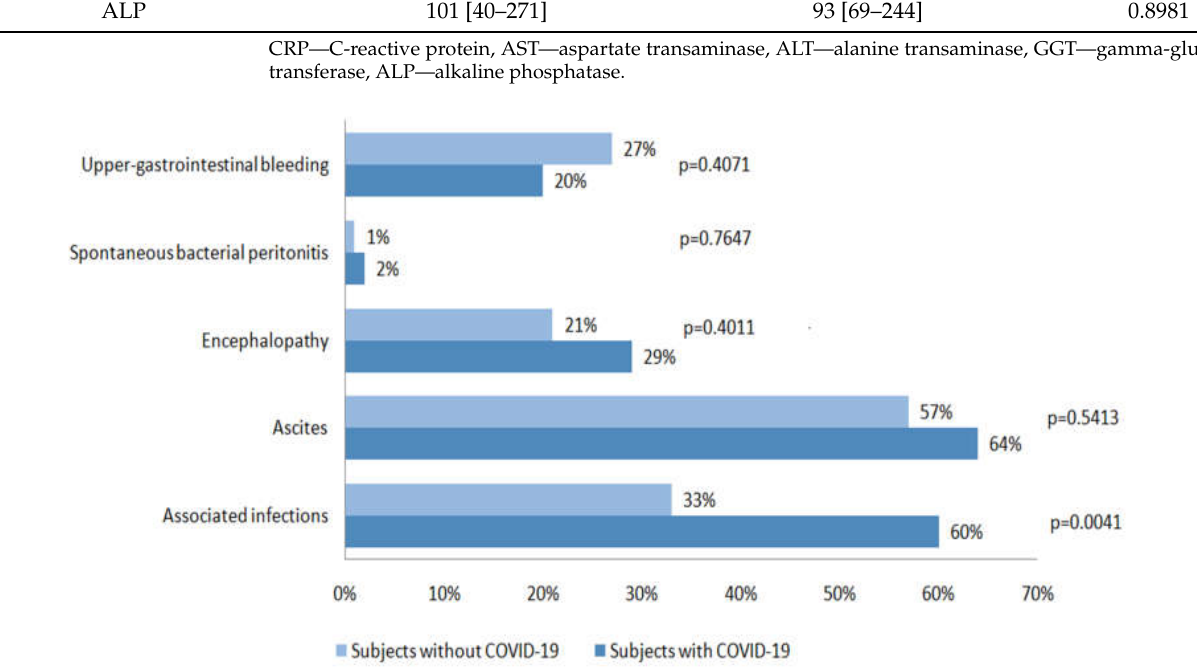
Figure 2. Factors of decompensation in the two groups.